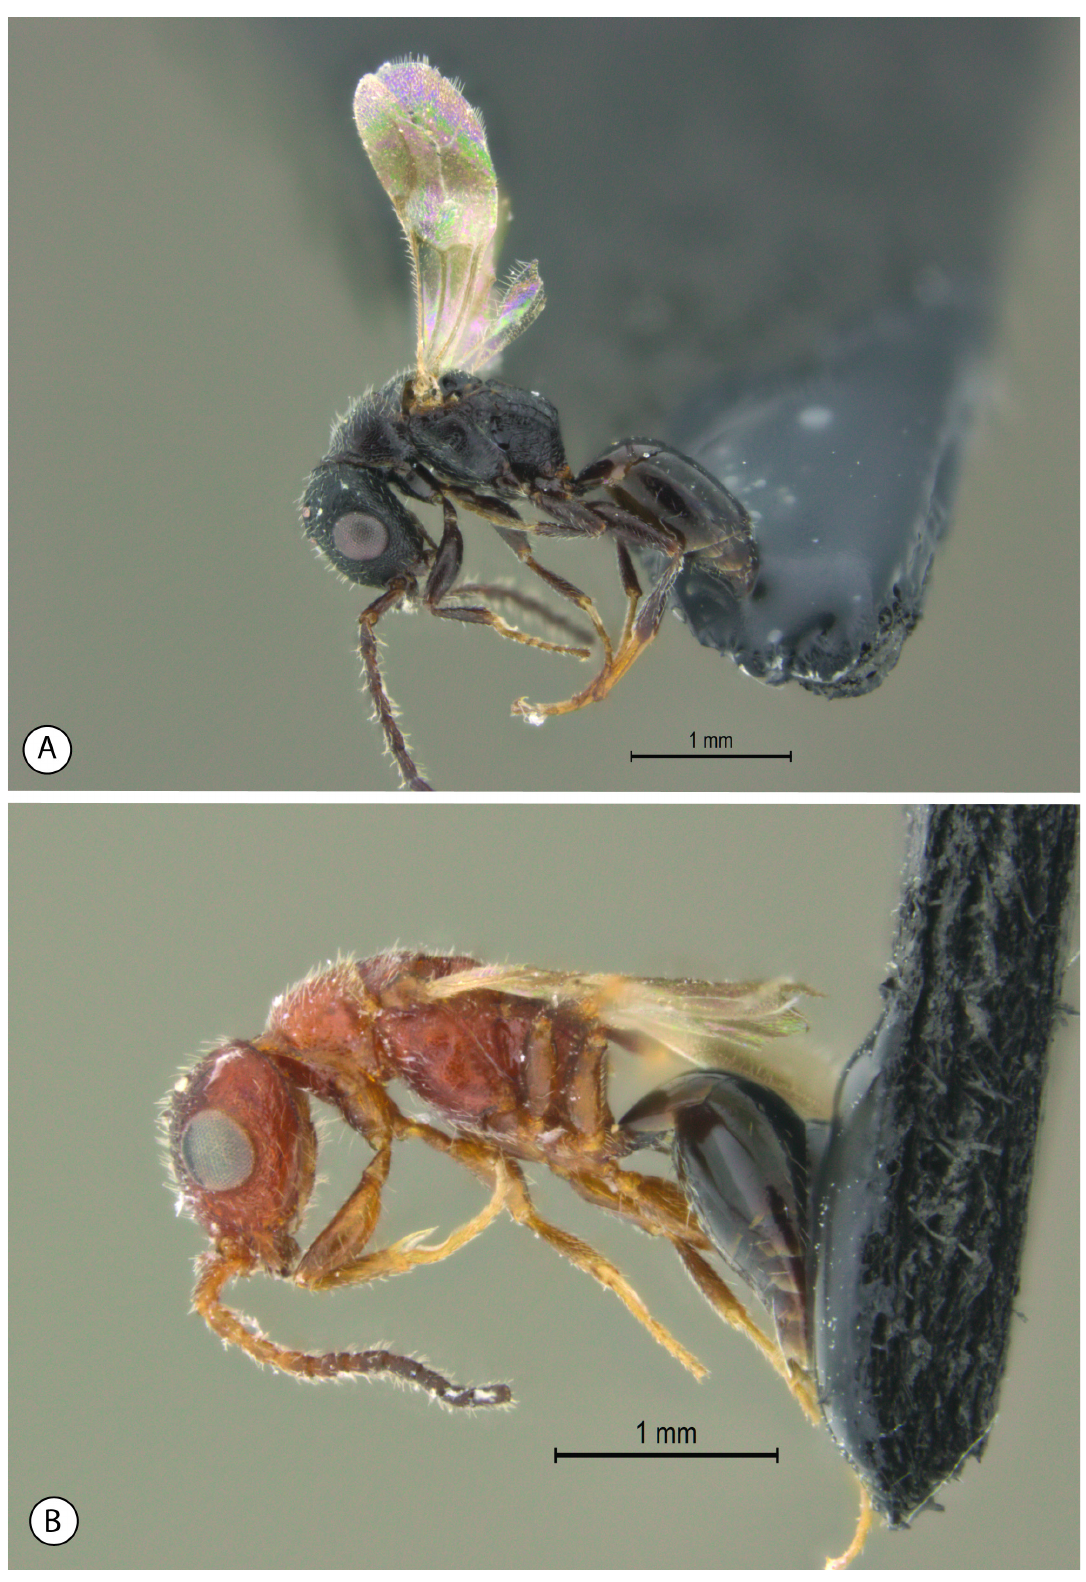
Fig. 6. Habitus of Astromesitius gen. nov. A . A. carbonarius (Móczár, 1970) gen. et comb. nov. (UFES 56168) B . A. indistintus (Barbosa & Azevedo, 2011) gen. et comb. nov. (paratype,